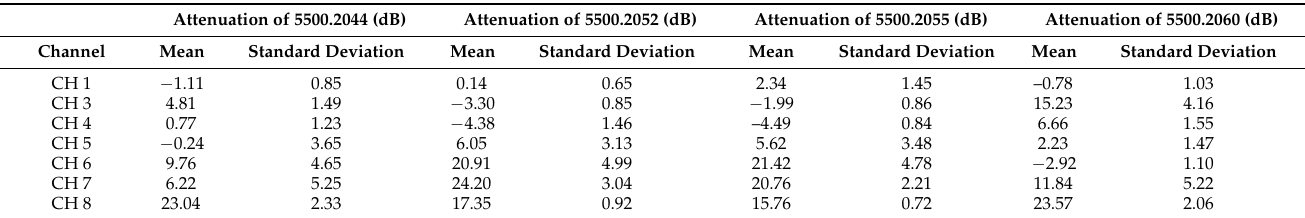
Table 5. Mean and standard deviation of signal attenuation due to the EMC filters in open circuit configuration. Attenuation of 5500.2044